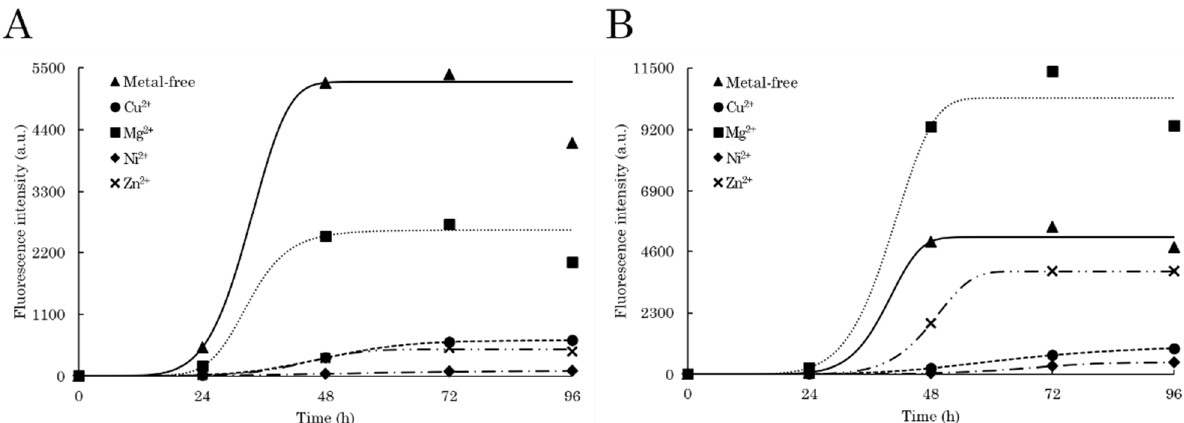
Figure 10. Sigmoid-fitted aggregation kinetic curves of ( A ) C-TERb and ( B ) C-TERa (C C-TER = 5 µ M) without metal (triangles, solid line) and in the presence of Cu 2+ (circles, dashed line), Mg 2+ (squares, dotted line), Ni 2+ (diamonds, dashed-dotted line), and Zn 2+ (crosses, dashed-double-dotted line) cations (C M2+ = 100 µ M), using dbAF emission at 456 nm ( λ ex = 400 nm, sw = 10 nm). Samples were incubated in TBS at ~20 °C for 96 h.